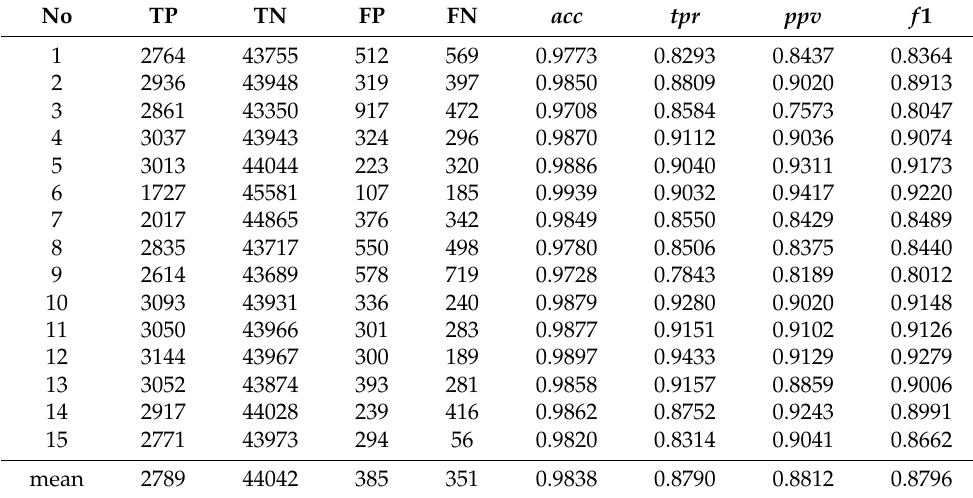
Table 9. Metrics calculated from SNAP_META, 2 × 50,000 pixels, 23 trees, OA = 0.8788 (compare mean value acc